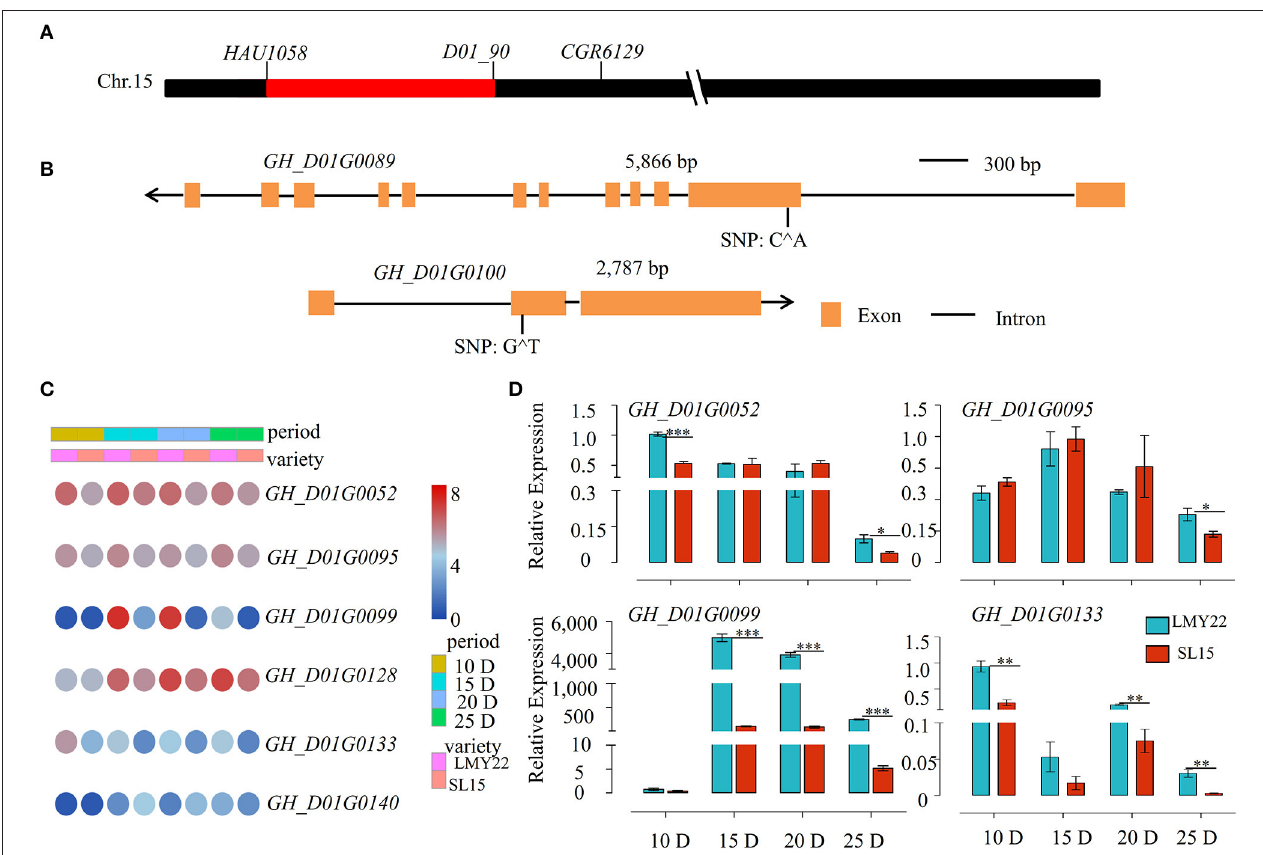
FIGURE 6 | Genetic structural variation and Expression patterns of candidate genes. (A) A schematic of introgressive segment on Chromosome 15 of SL15. (B) The genetic structural variation of candidate genes. Orange yellow boxes represent exons and black lines represent introns; the arrow represents the direction of genes on the chromosome. (C) Expression heat map for six candidate DEGs. (D) Expression of candidate genes as determined by qRT-PCR. * P < 0.05, ** P < 0.01, and *** P <